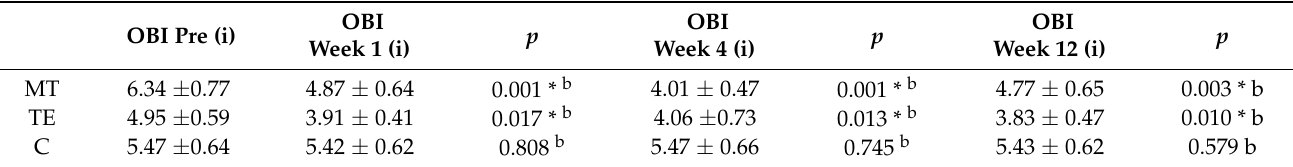
Table 3. Intergroup analysis for